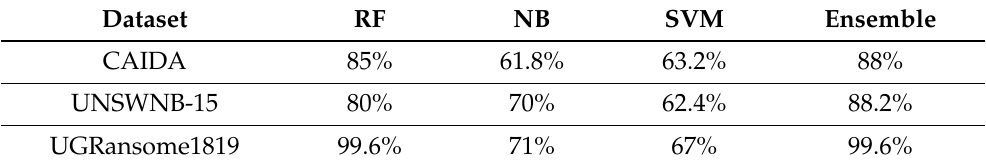
Table 9. Comparing the UGRansome1819’s Accuracy Prior Optimization.